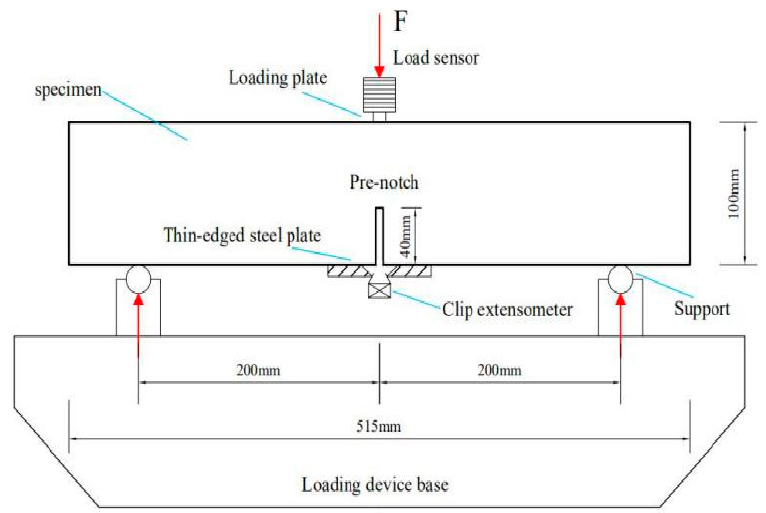
Figure 5. Schematic diagram of fracture test.